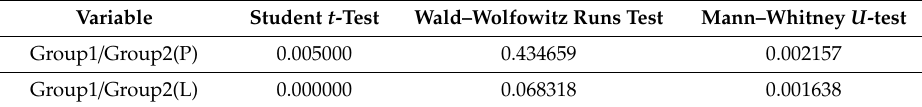
Table 9. Comparison of Group1 “cannabidiol (CBD)” and Group2 “placebo”